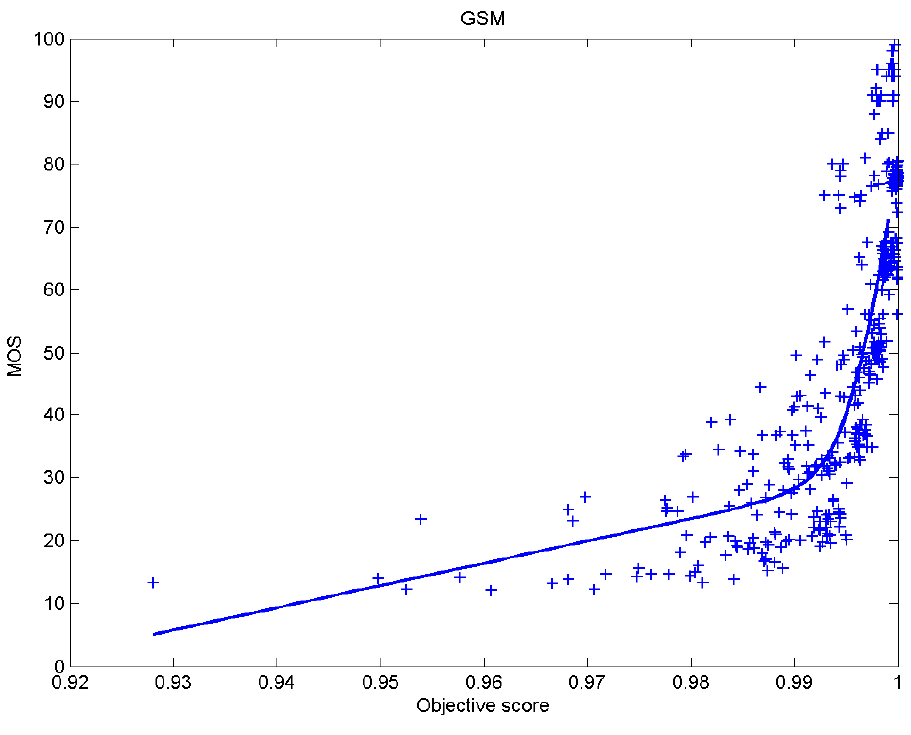
Figure 12. Scatter plots of the subjective scores (MOS) vs. GSM.